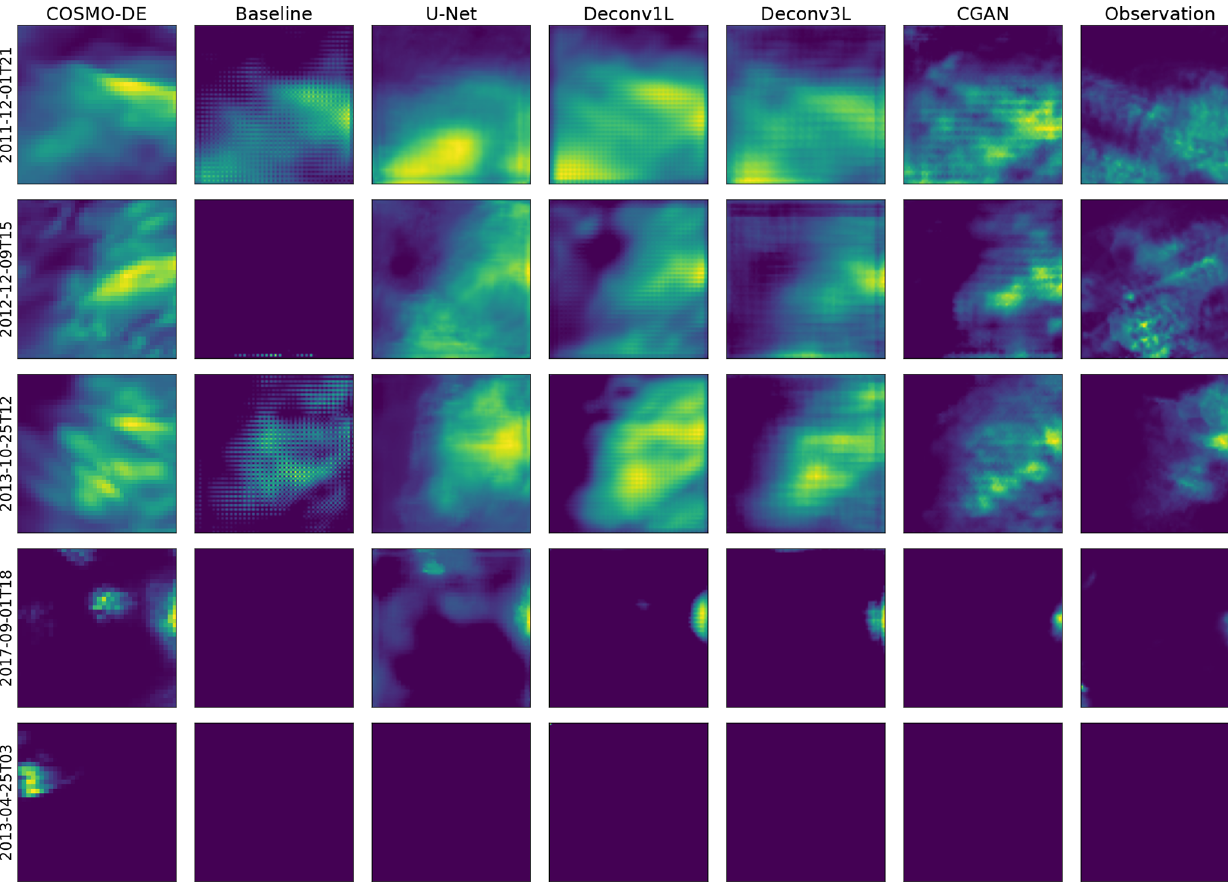
Figure 6. Example of predictions made by the different models versus the true values. For each of the models, the initialization with the highest LEPS-based skill score was selected to generate the